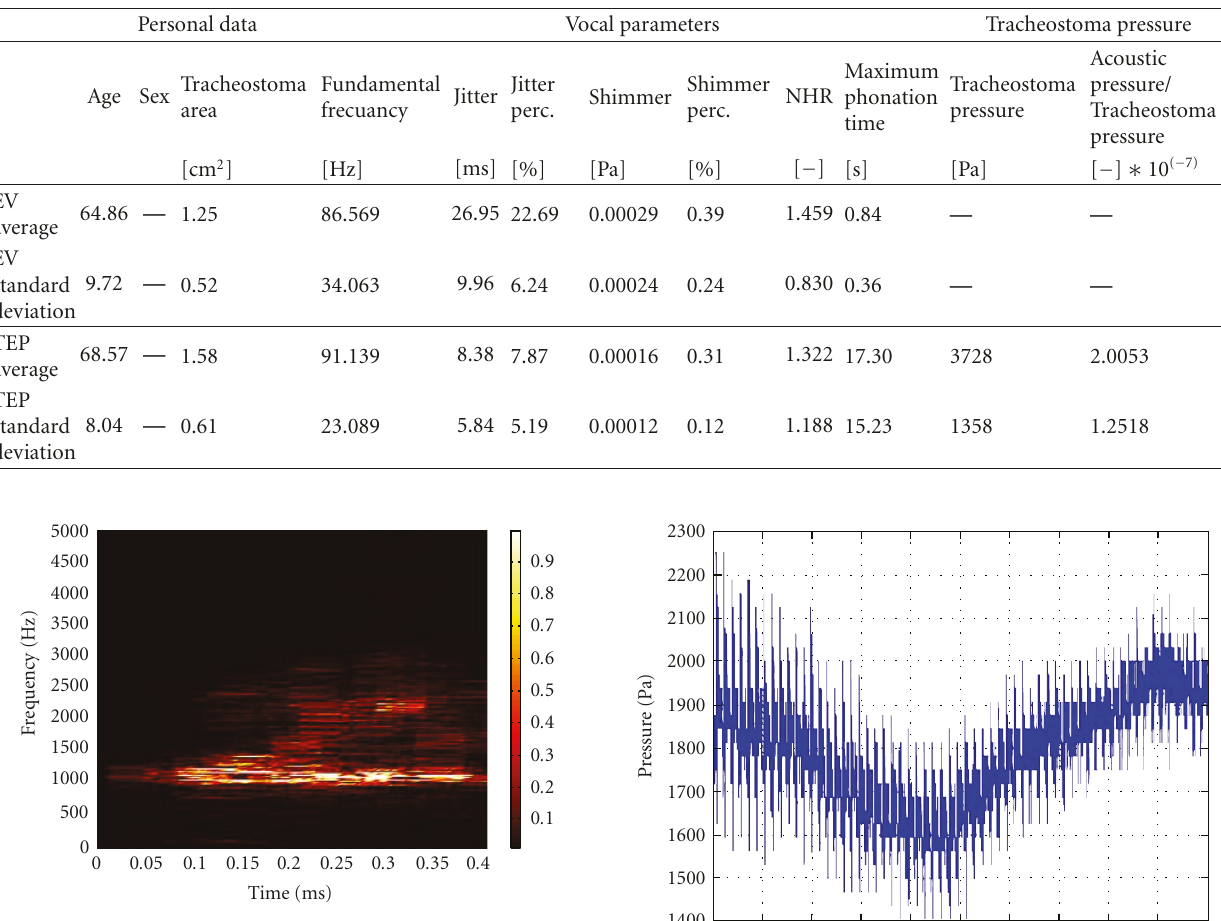
Figure 7: Vocal signal frequency versus time (TEP3).